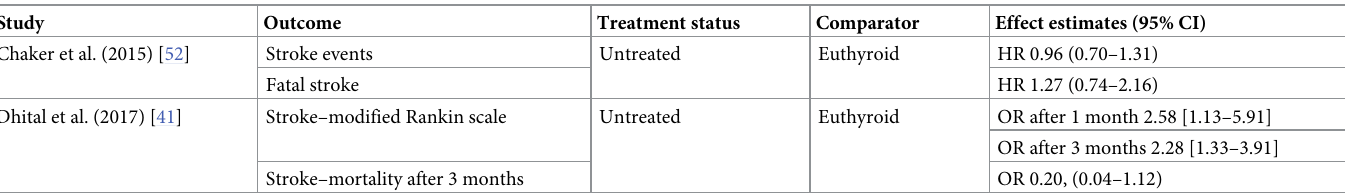
Table 6. Primary review findings on stroke.